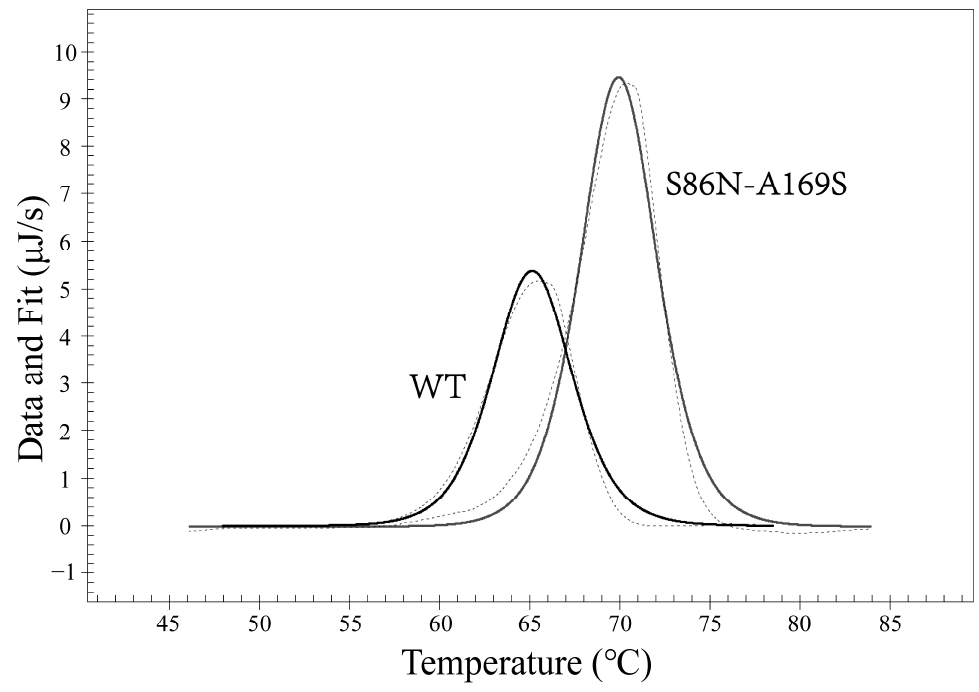
Figure 14. Differential scanning calorimetry (DSC) analysis on antibody stability. The melting dissolution temperature (Tm) of the WT and S86N-A169S were 65.25 °C and 70.02 °C, respectively. The dashed line shows the raw data, and the solid line shows the fitting curve.